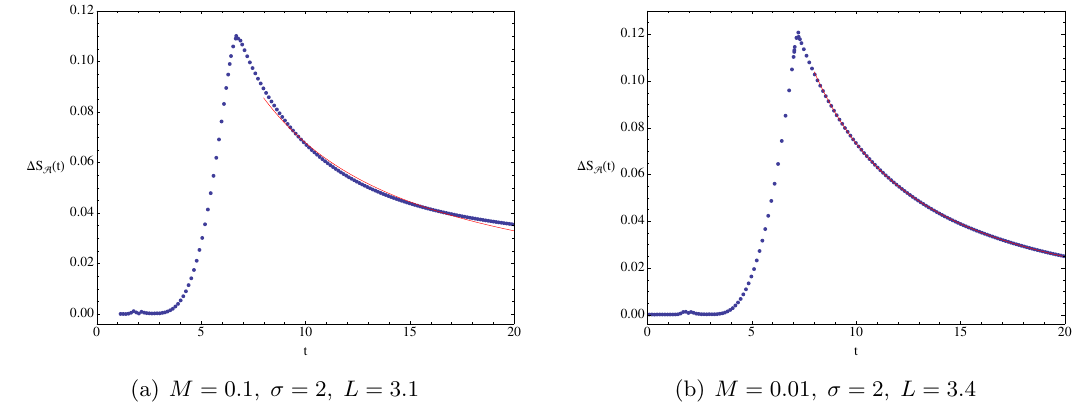
Figure 4 . The decay of (cid:1) S A ( t ) and its best logarithmic (cid:12)t for Q = 0 : 99 Q ext and (cid:11) = 0 : 1. The sizes L have been chosen such that the extremal surfaces probe the near-horizon geometry at one point during the quench’s evolution, i.e. L is taken as large as the quench allows it to be. We (cid:12)nd (cid:14) = 1 : 5 for the (cid:12)gure on the right.